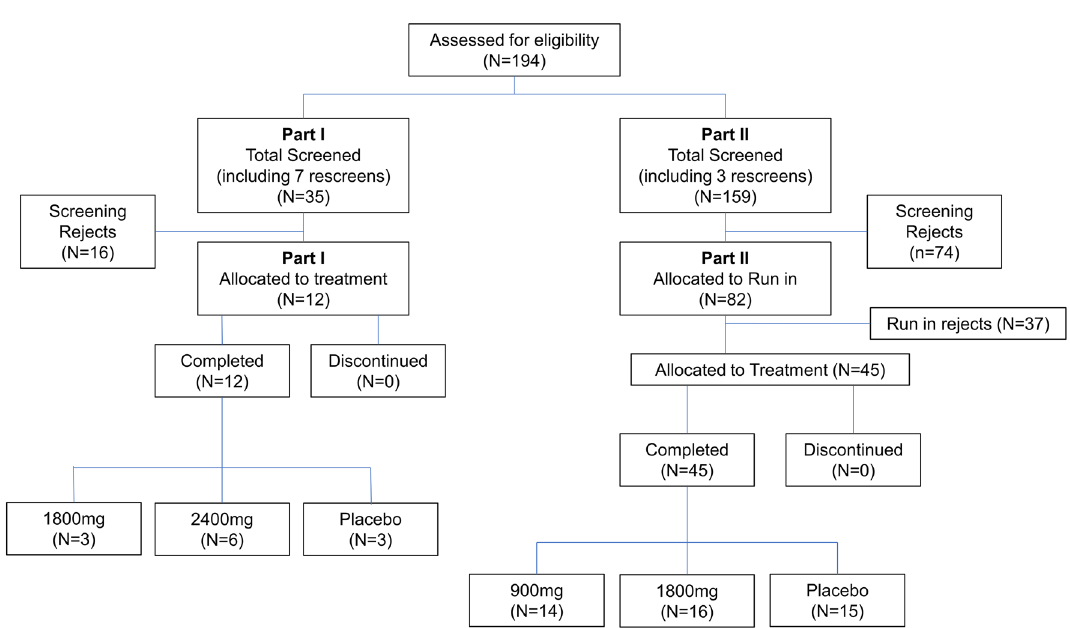
Figure 3. Consort diagram. Cardiac safety of nolasiban was assessed during part II of this study. The sample size in part I did not allow for meaningful statistical analysis, therefore, only data from part II was used during the cardiac safety